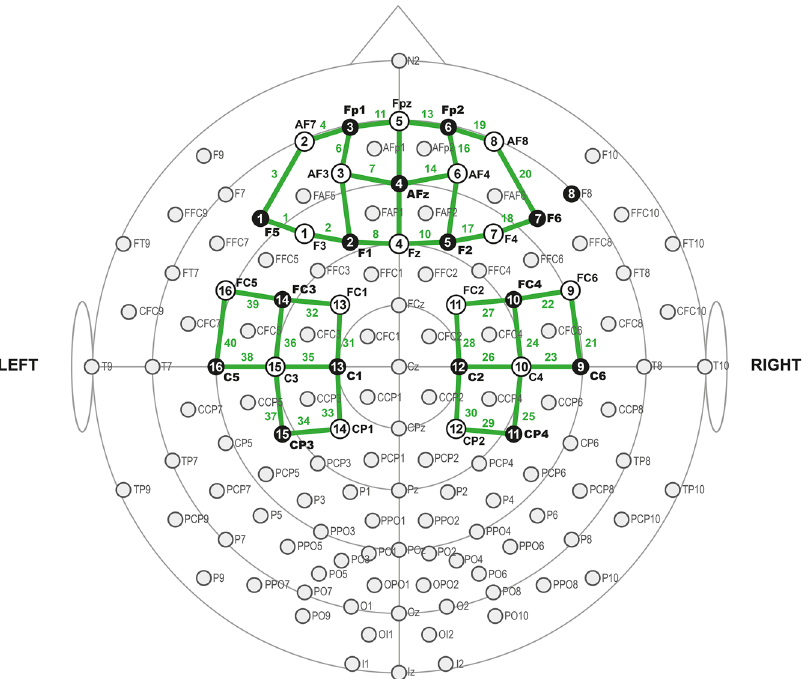
Figure 1. The fNIRS’ optodes montage. Black dots represent detectors, and white dots represent sources. Left prefrontal cortex—channel 1–9 plus 11 and 12. Right prefrontal cortex—channel 12–20 plus Channel 9 and 10. Right motor cortex—channel 21–30. Left motor cortex—Chanel